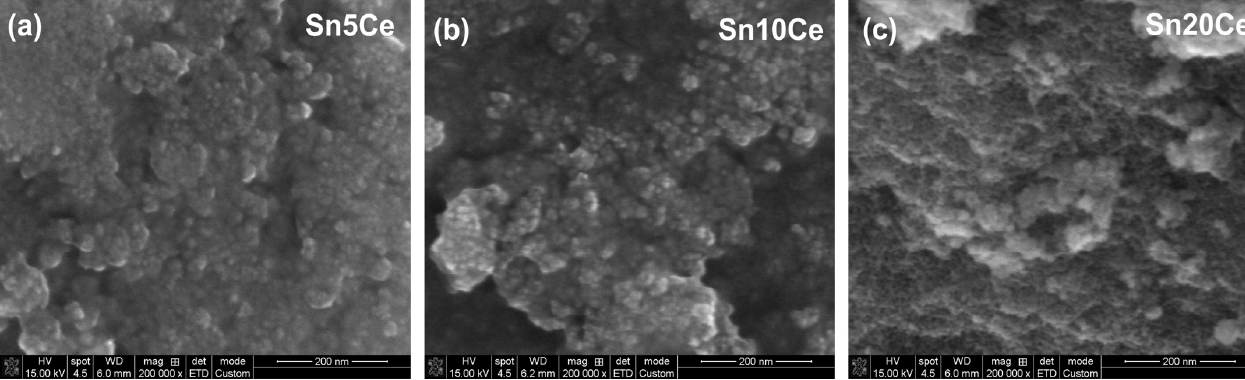
Figure 12. SEM image of the SnO 2 -CeO 2 sensitive powder samples with: ( a ) 5%SnO 2 ; ( b ) 10% SnO 2 ; and ( c ) 20% SnO 2 , from ref. [40].